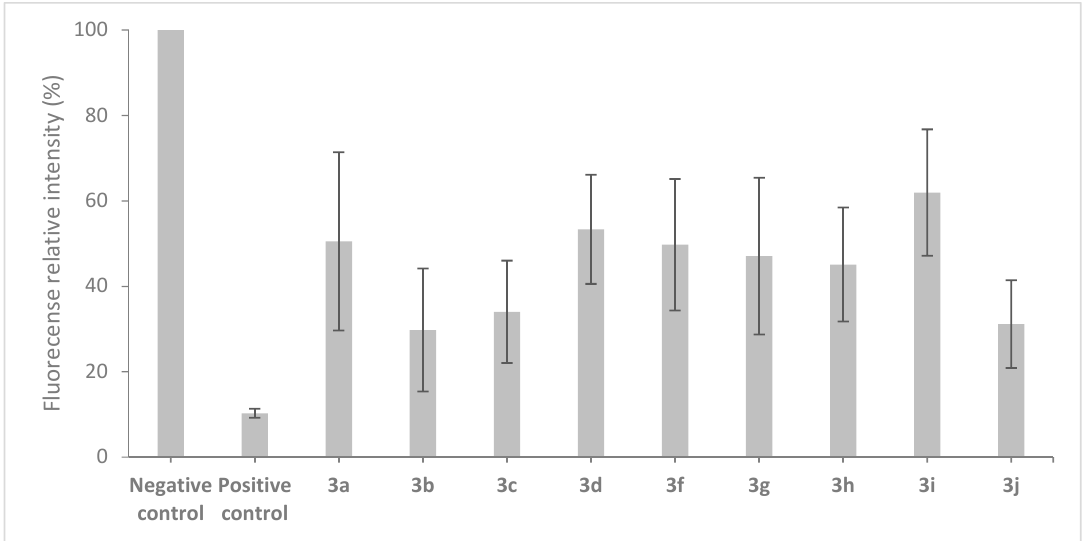
Figure 3. Effect of the compounds on the cell wall integrity of B. cinerea . The effect was measured as relative fluorescence intensity compared to maximum fluorescence (negative control).